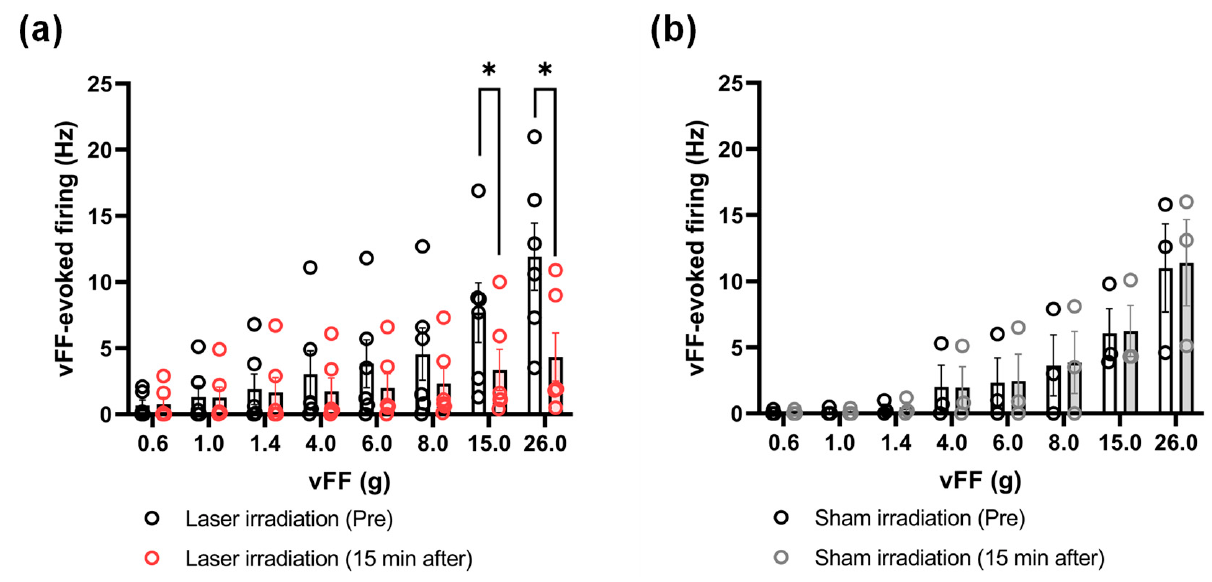
Figure 3. Comparison of frequencies among the 0.6, 1.0, 1.4, 4.0, 6.0, 8.0, 15.0, and 26.0 g vFF-evoked firing at 15 min after laser irradiation, when the 26.0 g vFF-evoked firing was the most inhibited. ( a ) The 15.0 and 26.0 g vFF-evoked firing was significantly inhibited while there were no significant differences in the 0.6, 1.0, 1.4, 4.0, 6.0, and 8.0 g vFF-evoked firing. ( b ) There were no significant differences for all vFFs after sham irradiation. The data are presented as the means ± SEM; * p < 0.05 vs. Pre using Wilcoxon matched-pairs signed-rank test ( n = 3–6); vFF, von Frey filaments; SEM, standard error of the mean.